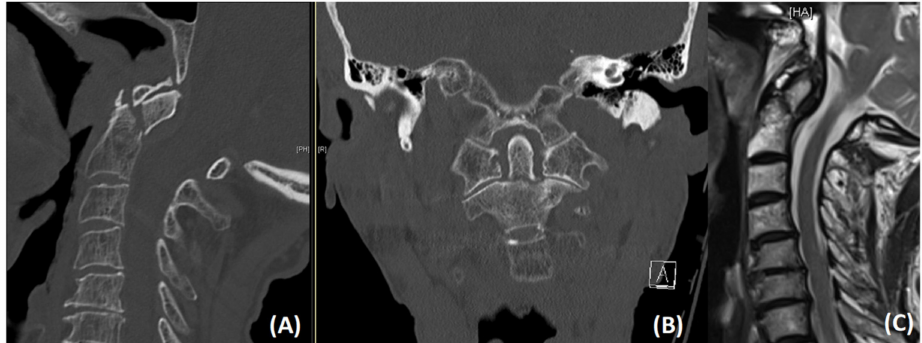
Figure 1. Sagittal ( A ) and coronal ( B ) CT images showing an unstable dislocated odontoid type II fracture in a 90-year old male patient. T2-weighted sagittal MR image ( C ) illustrating a slight anterior spinal cord